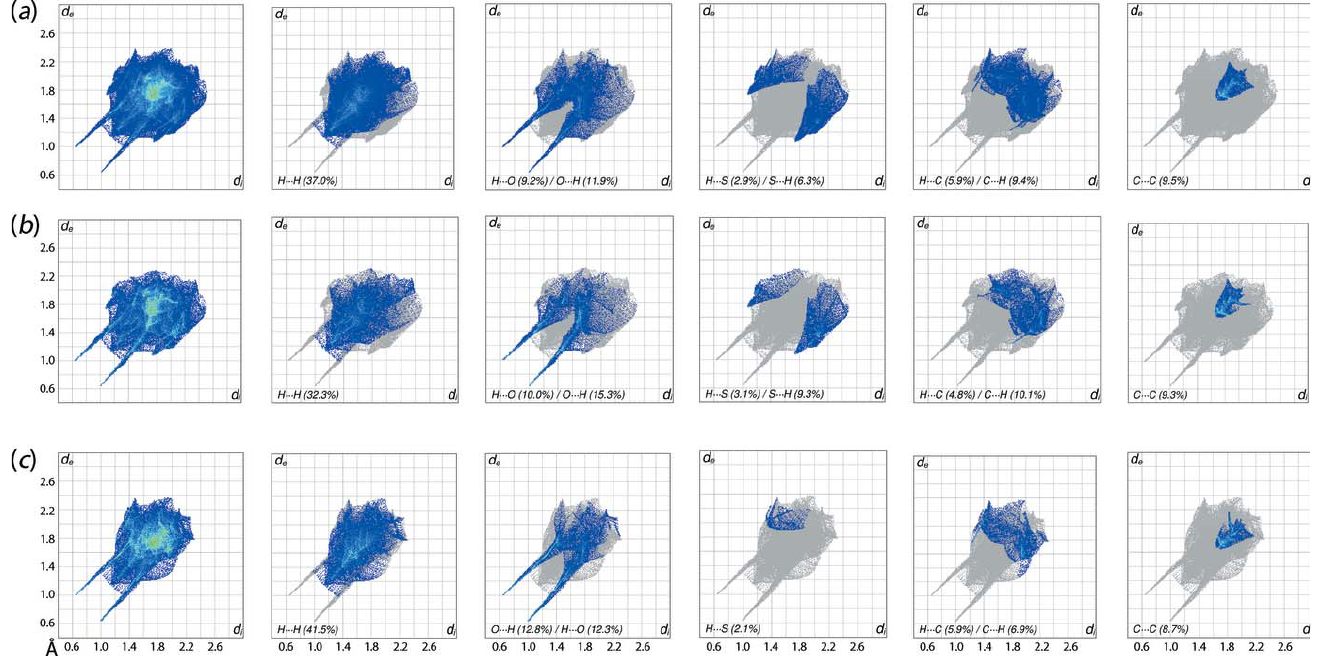
Figure 5 The full two-dimensional fingerprint plot and those delineated into H (cid:2)(cid:2)(cid:2) H, O (cid:2)(cid:2)(cid:2) H/H (cid:2)(cid:2)(cid:2) O, S (cid:2)(cid:2)(cid:2) H/H (cid:2)(cid:2)(cid:2) S, C (cid:2)(cid:2)(cid:2) H/H (cid:2)(cid:2)(cid:2) C and C (cid:2)(cid:2)(cid:2) C contacts for ( a ) (I), ( b ) DTBA and ( c ) BA, respectively.